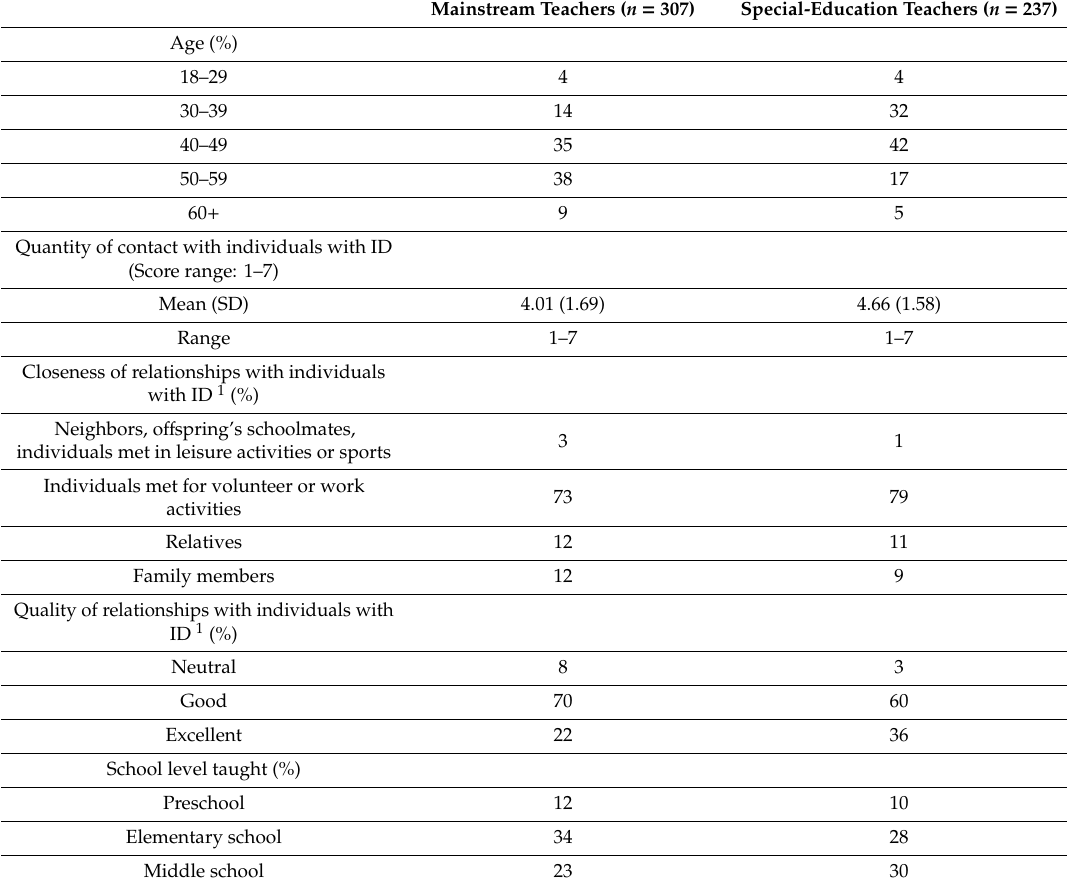
Table 1. Characteristics of the mainstream and special-education